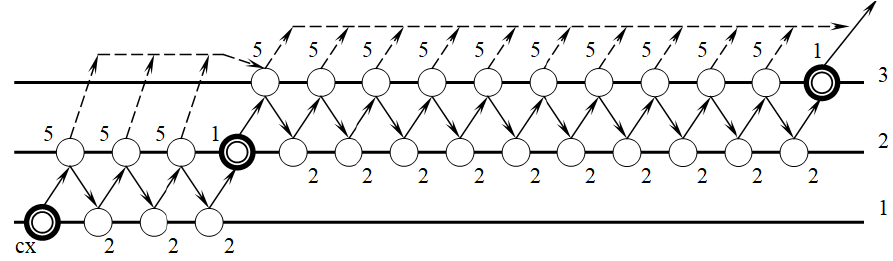
Figure 5. Scheme of the multi ‐ grid AMA algorithm.